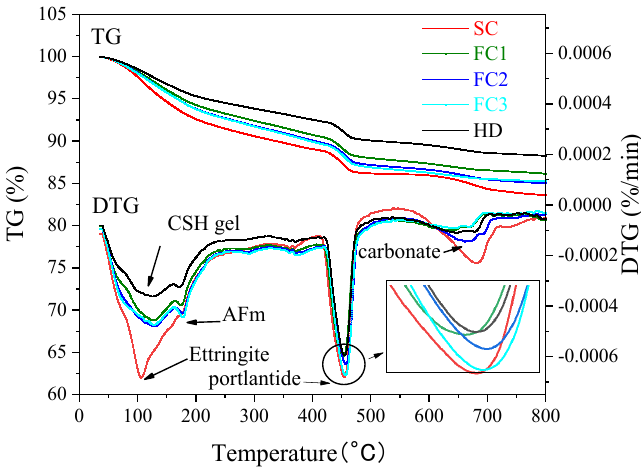
Figure 15. TG-TDG curves of FA25-P under different curing systems.